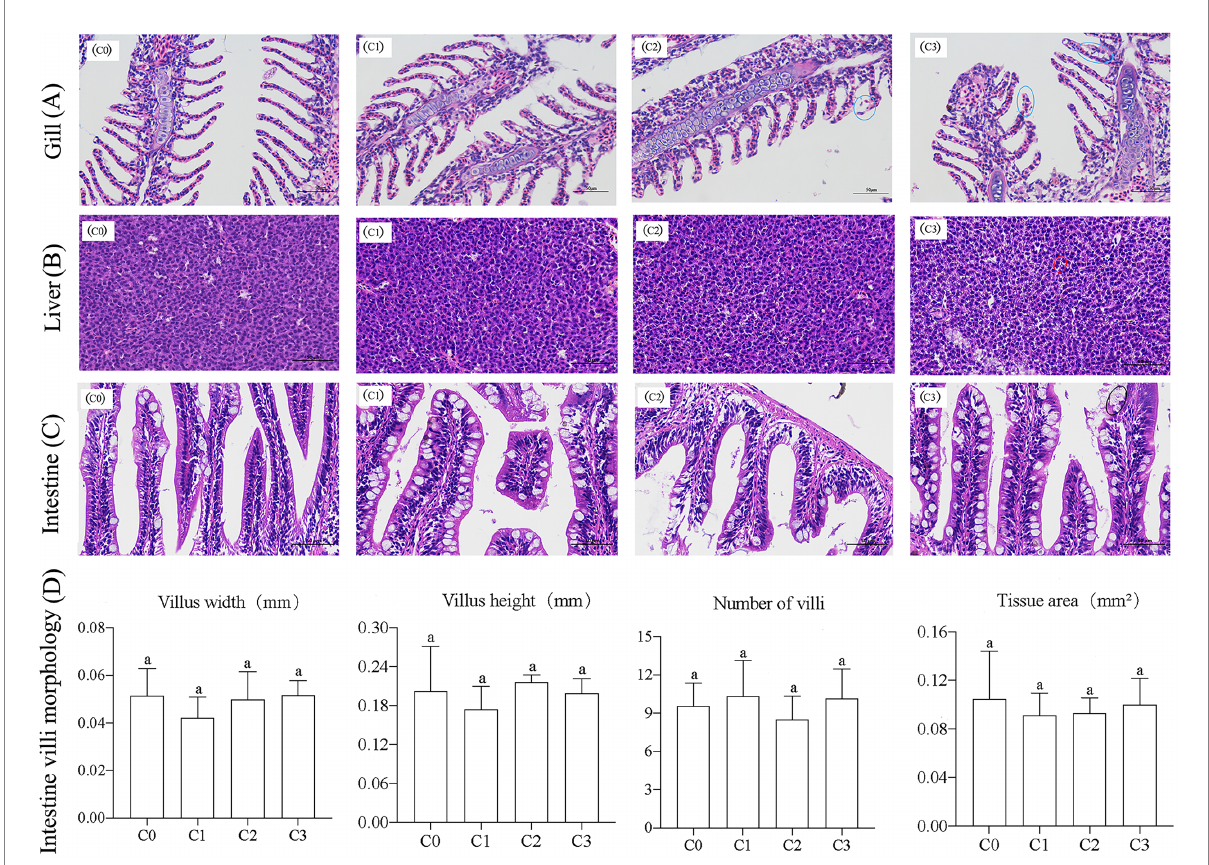
FIGURE 5 Effects of AVH-AgNPs on gills (A) , livers (B) , intestines (C) , and intestinal villi (D) of zebrafish. C0, C1, C2, and C3 refer to 0, 6, 9, and 18 μ g/l of AVH- AgNPs, respectively. Values are expressed as mean ± SE ( n = 3). Bars with the same letters indicate no significant differences ( p >